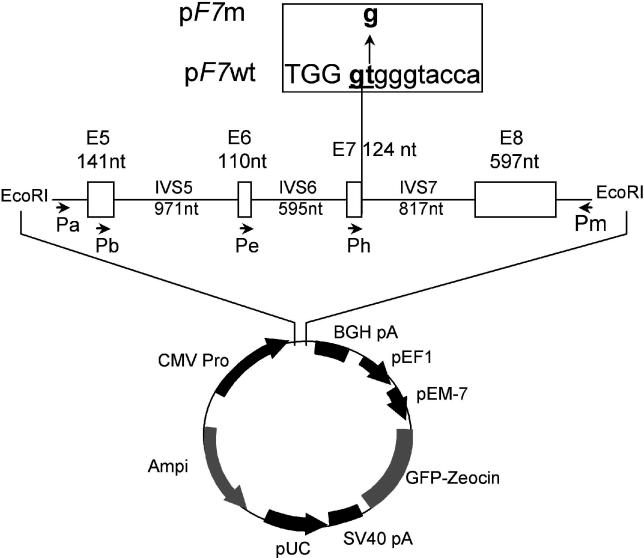
Schematic Representation of the Human F7 Gene and Wild-Type and Mutant F7 Minigenes Cloned into pTracer-CMV VectorSizes of exons (E, open boxes) and introns (I, horizontal lines) are indicated. Primers Pa, Pb, Pe, Ph, and Pm are represented by horizontal arrows indicating their respective positions in the minigene sequence. Inset indicates the last three nucleotides of exon 7 (capital letters) and the first ten nucleotides of IVS7 (in lowercase characters) of the wild-type F7 gene. The invariant gt dinucleotide is indicated in underlined bold letters. A vertical arrow indicates the nucleotide change in the mutant sequence.